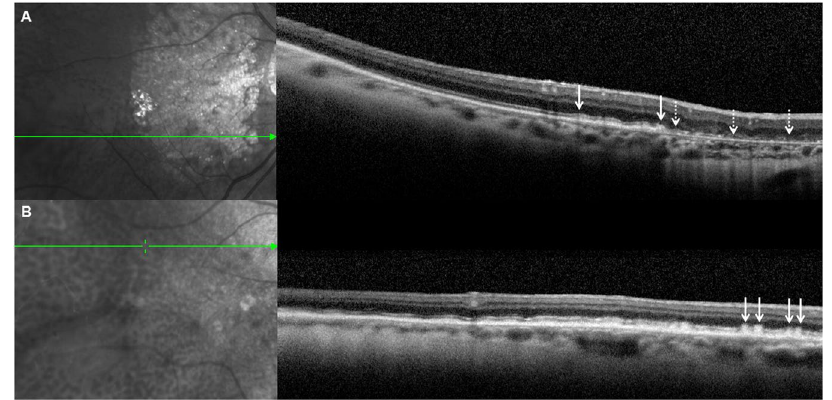
Figure 3. SD-OCT pattern in EMAP-pseudodrusen ( A ) and in age-related pseudodrusen ( B ). The deposits are above the RPE in both cases. In EMAP ( A ), the deposits have a diffuse pattern (between white arrows) adjacent to the macular atrophic lesion (dotted line arrows). In AMD ( B ), pseudodrusen have a nodular pattern (white